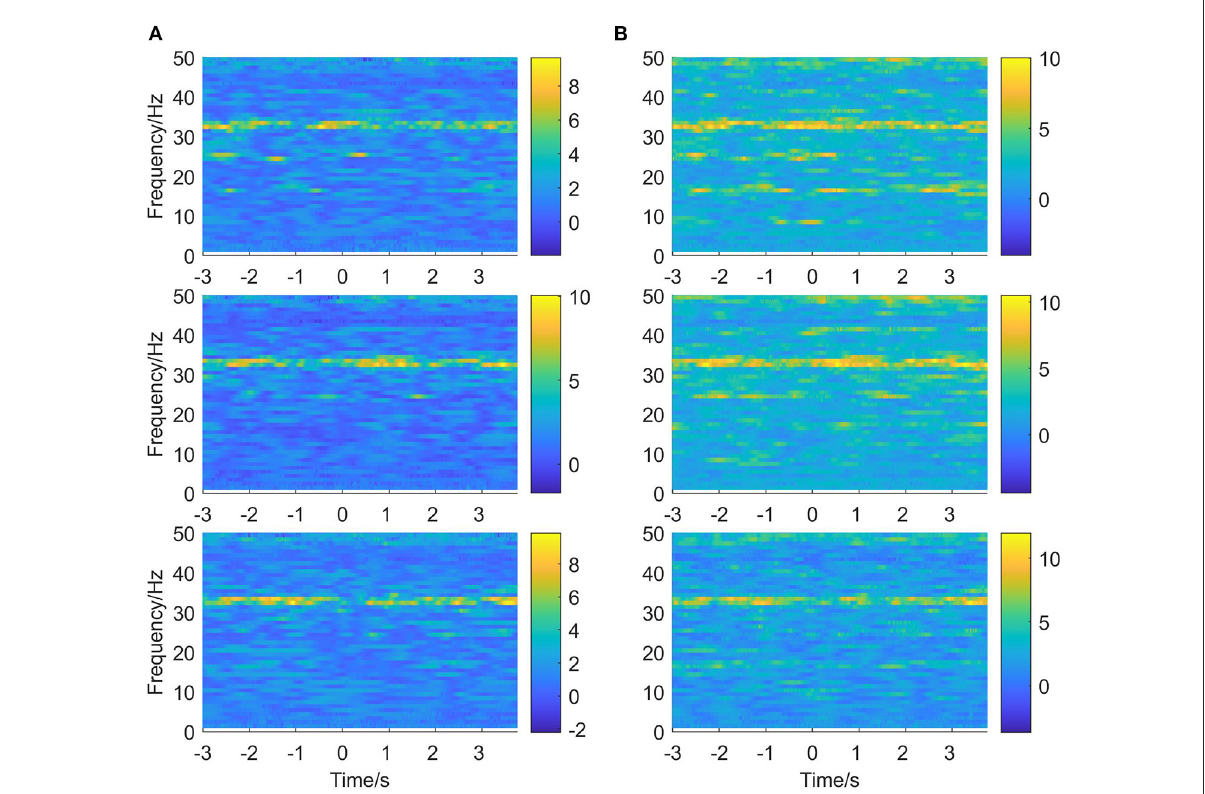
FIGURE5 Time-frequency plots of EEG-EMG GC in the two directions of EEG → EMG and EMG → EEG under different hand-grasping movements (from top to bottom, card, ball, and cup hand-grasping movement, respectively). (A) EMG → EEG, (B) EEG →